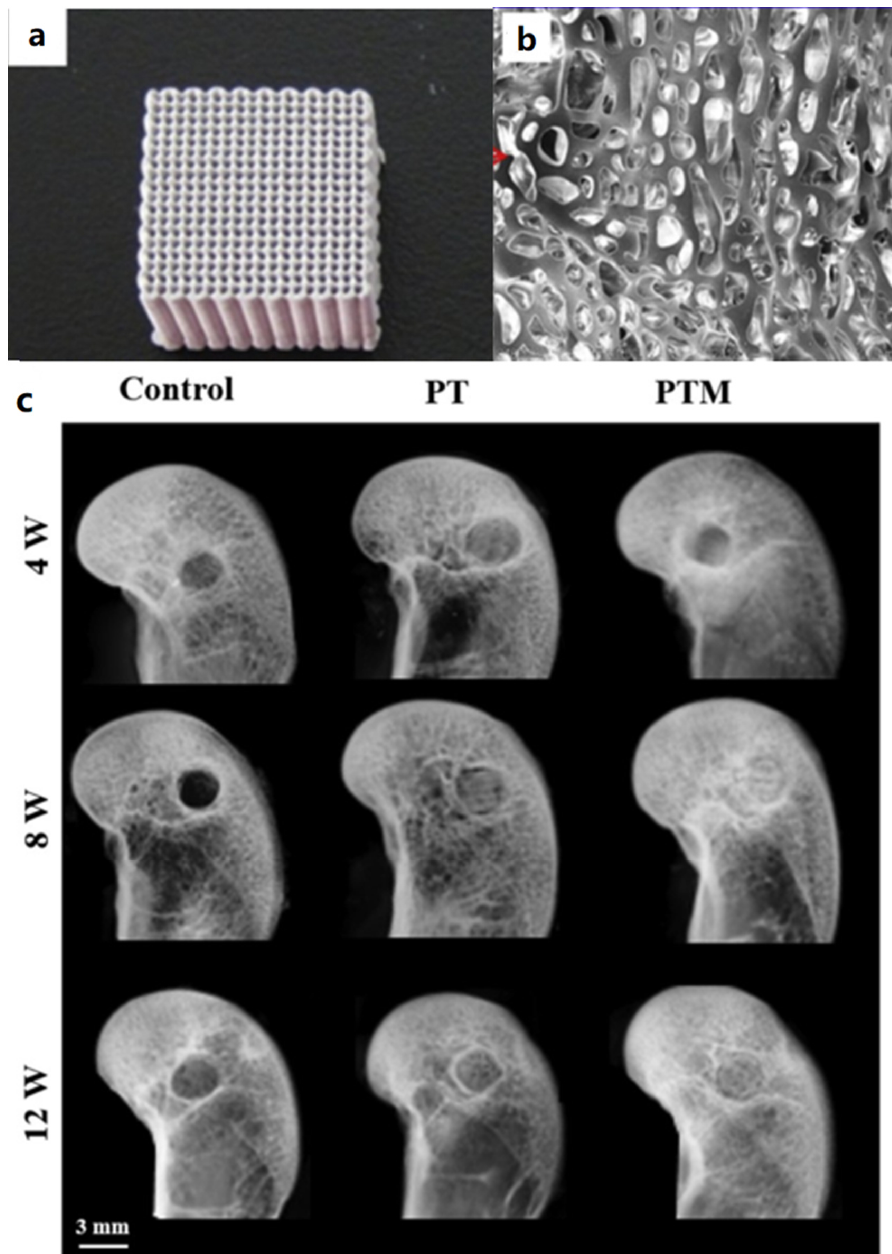
Figure 2. PTM scaffolds show excellent mechanical strength and osteogenic properties. ( a ) PTM scaffolds. ( b ) The porous surface structure ensures good biocompatibility of PTM scaffolds. ( c ) Rabbit model of femur defect repaired with PTM scaffolds, Reprinted with permission from ref. [35]. Copyright 2019